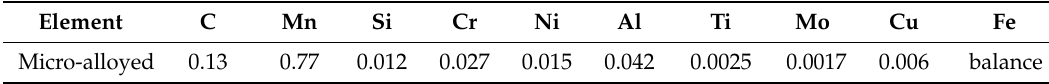
Table 1. Chemical composition of as-received micro-alloyed steel (MAS) (wt %).